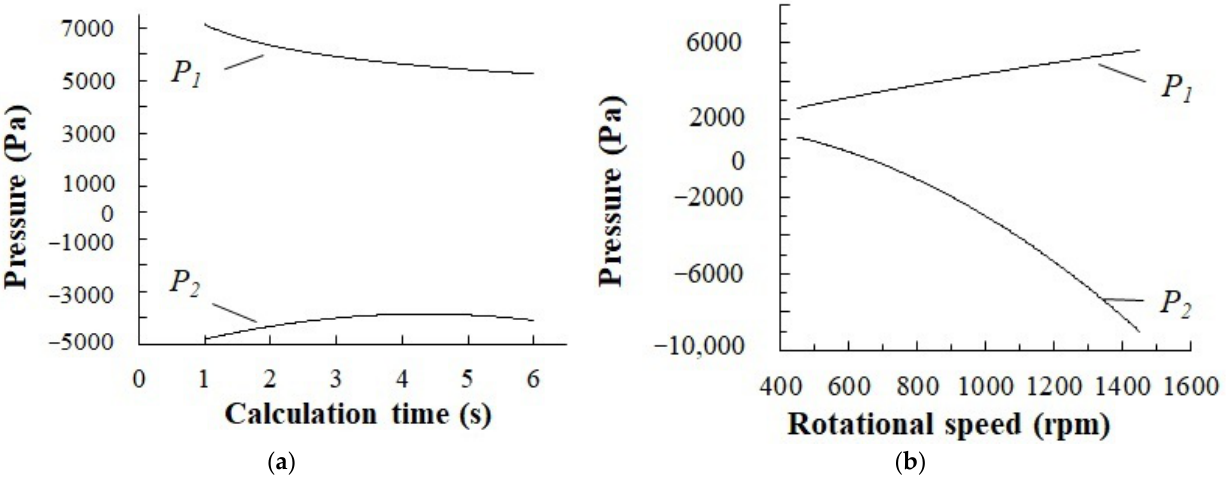
Figure 6. Changes in the maximum ( P 1 ) and minimum ( P 2 ) pressure in the fluid with time in simulation ( a ) n = 1000 (rpm), h = 0.05 (m), and the stirrer rotational speed ( b ). The stirring process simulation (Figure 7b) demonstrates that the reduced pressure regions occur along the entire paddle height (point 1–3). The paddle height increase causes the local region size increase. This is the process driver that conditions the supply of gas from the vortex cavity into the entire volume of liquid, therefore ensuring the gas content growth. ( a )